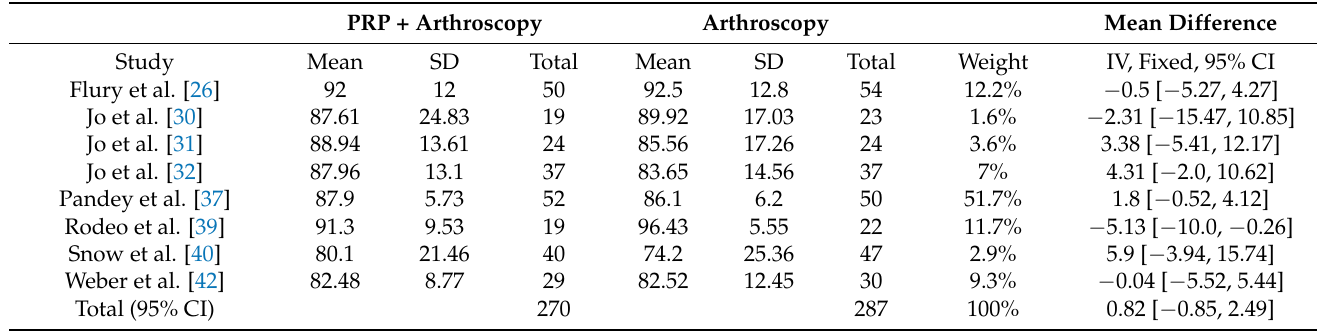
Table 4. Comparison of post-operative ASES scores between PRP and control groups at final follow-up.